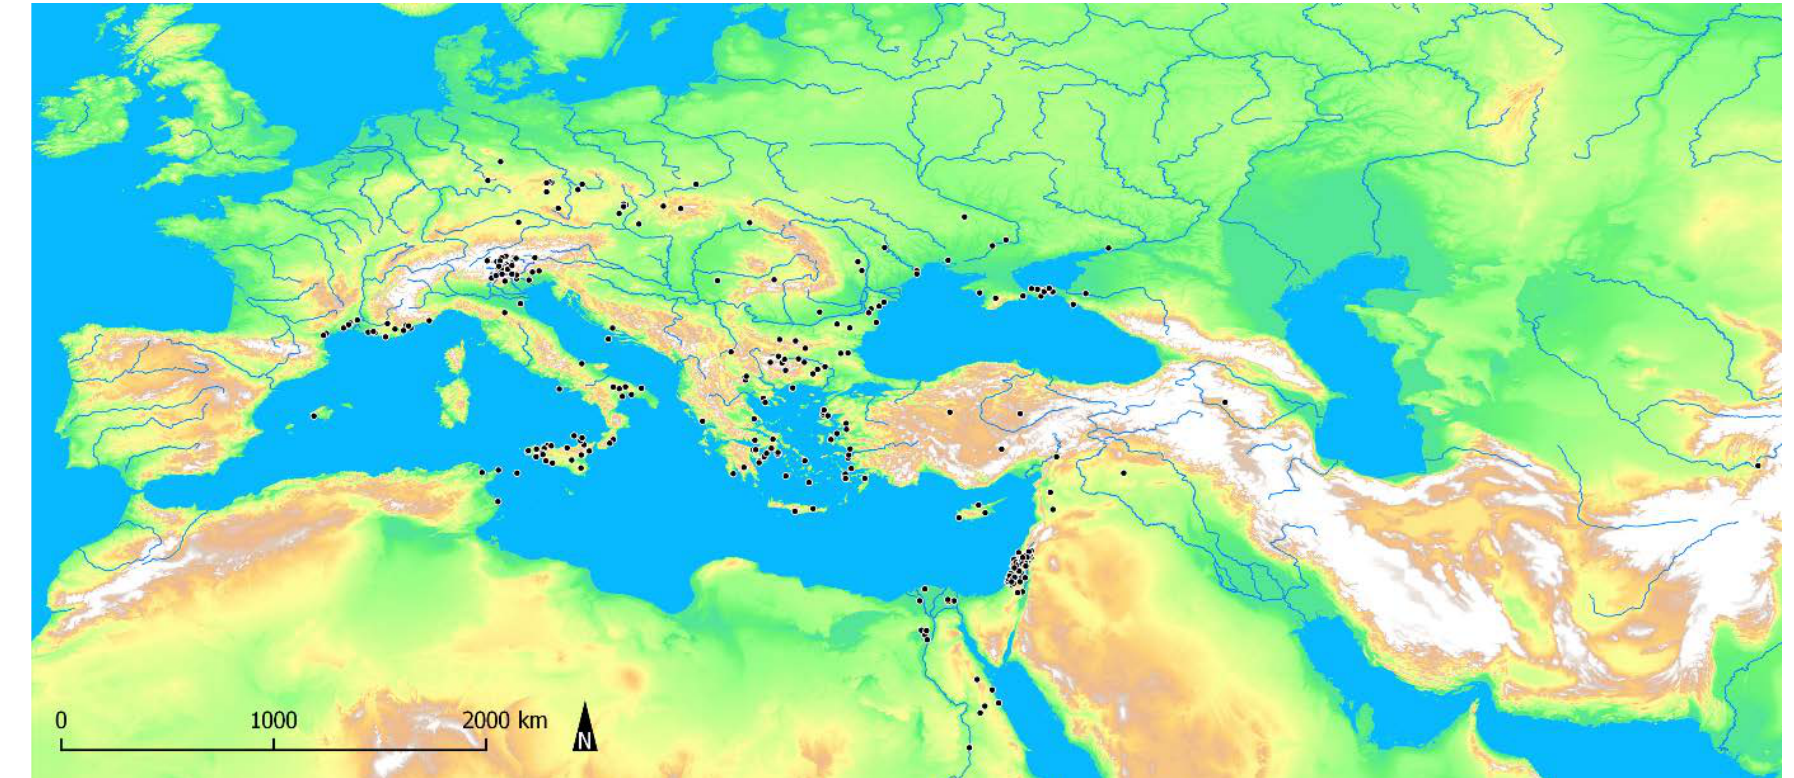
Figure 3. Distribution map with more than 300 Olynthus mill discovery sites (see Francisci 2017 and Figures 10-13 with related list of sites in supplementary